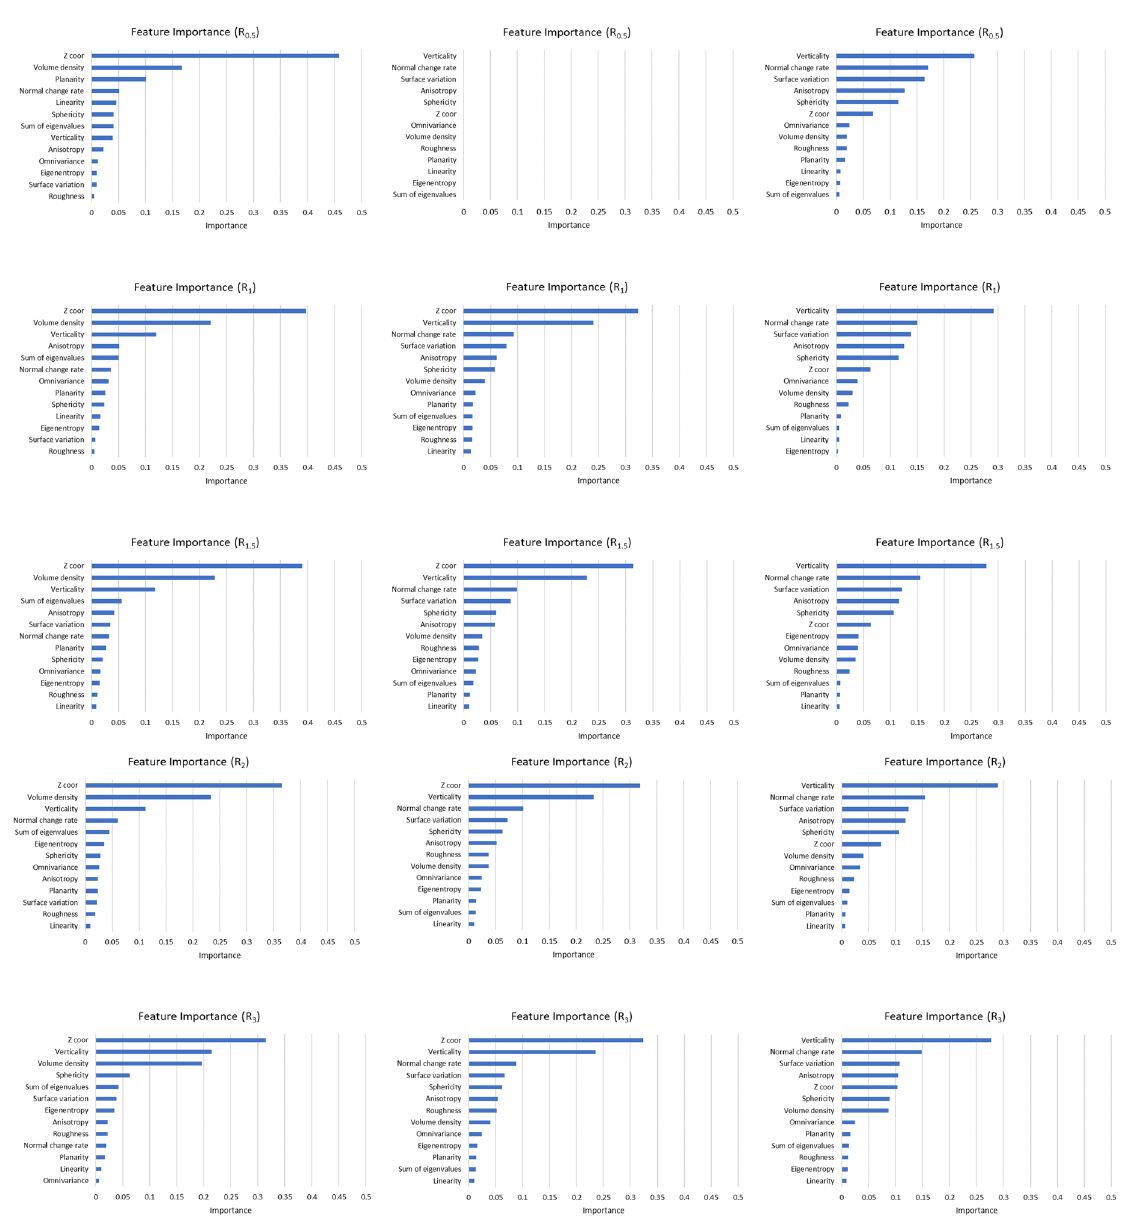
Figure 16. Feature importance rankings. (For Dublin City on the left side; for Vaihingen on the middle; Oakland3D on the right side).